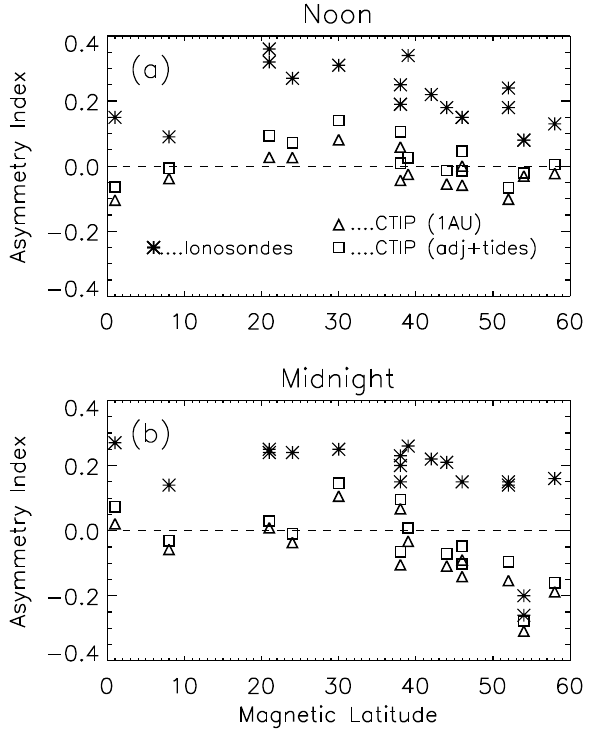
Fig. 2. Asymmetry index of Nm F2 for station pairs A-Q. Stars show values from ionosonde data, diamonds show CTIP values, computed with varying Sun-Earth distance. Above, noon; be- low, midnight. See Fig. 1 and Table 1 for station pairs. Mid- night ionosonde values are not given for Singapore-Talara and Washington-Watheroo.